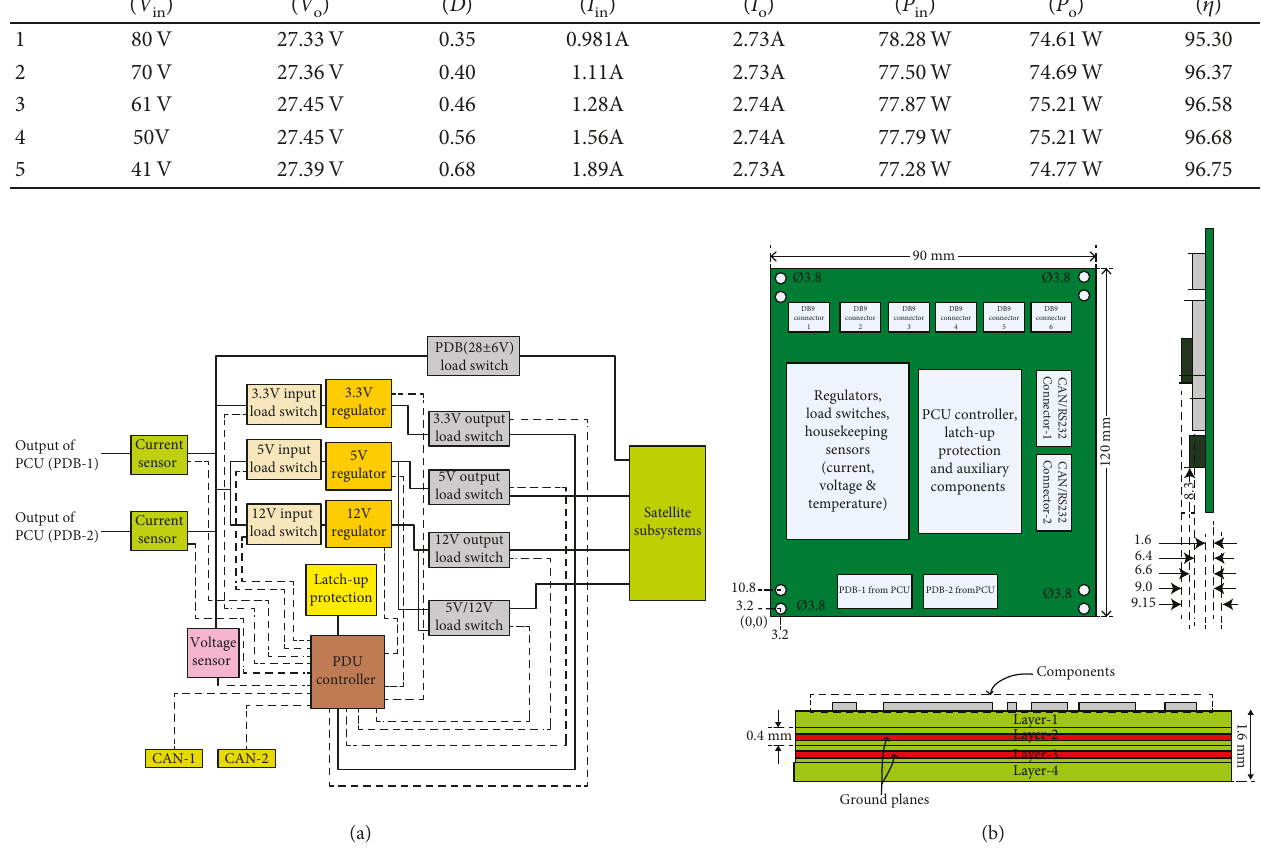
Figure 18: (a) PDM block diagram and (b) PCB